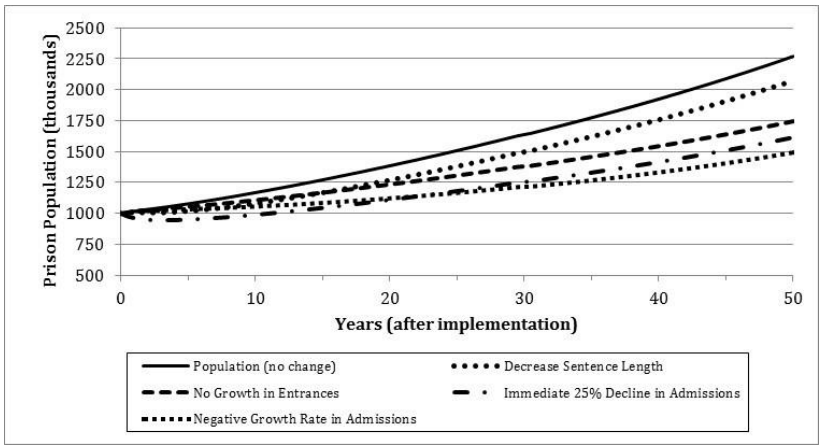
Figure 2. Complete Inmate Population, Changes in Policies for Nonviolent Offenders. Source: Calculations by author using Bureau of Justice Statistics data.